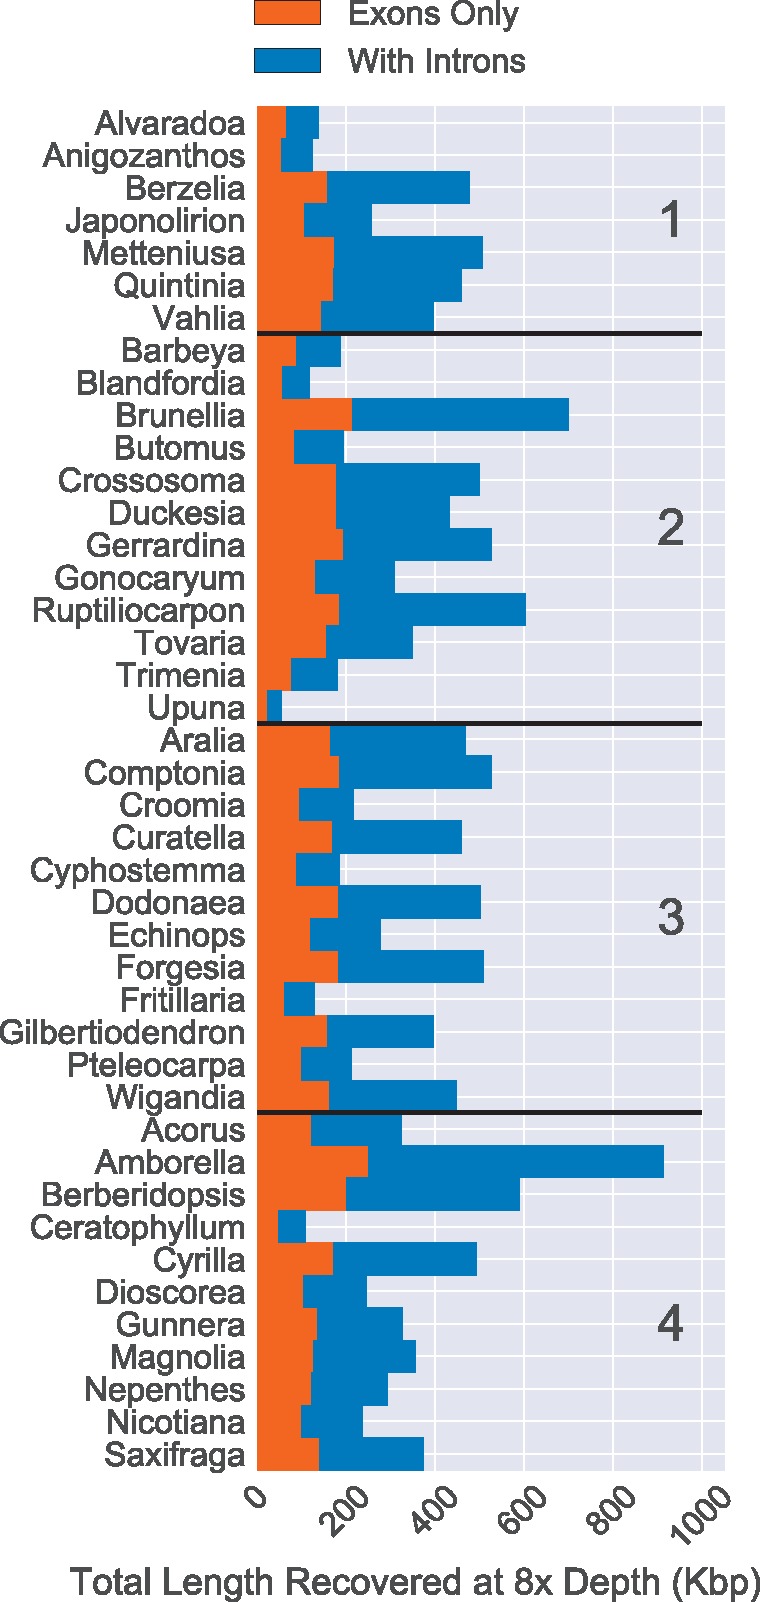
Total length of sequence recovery for both coding and non-coding regions across 353 loci for 42 angiosperm species. Reads were mapped back to either coding sequence (left bar) or coding sequence plus flanking non-coding (i.e., intron) sequence (right bar). Only positions with at least 8\documentclass[12pt]{minimal}
\usepackage{amsmath}
\usepackage{wasysym}
\usepackage{amsfonts}
\usepackage{amssymb}
\usepackage{amsbsy}
\usepackage{upgreek}
\usepackage{mathrsfs}
\setlength{\oddsidemargin}{-69pt}
\begin{document}
}{}$\times$\end{document} depth were counted. The total length of coding sequence targeted was 260,802 bp. The median recovery of coding sequence was 137,046 bp and the median amount of non-coding sequence recovered was 216,816 bp (with at least 8\documentclass[12pt]{minimal}
\usepackage{amsmath}
\usepackage{wasysym}
\usepackage{amsfonts}
\usepackage{amssymb}
\usepackage{amsbsy}
\usepackage{upgreek}
\usepackage{mathrsfs}
\setlength{\oddsidemargin}{-69pt}
\begin{document}
}{}$\times$\end{document} depth of coverage).